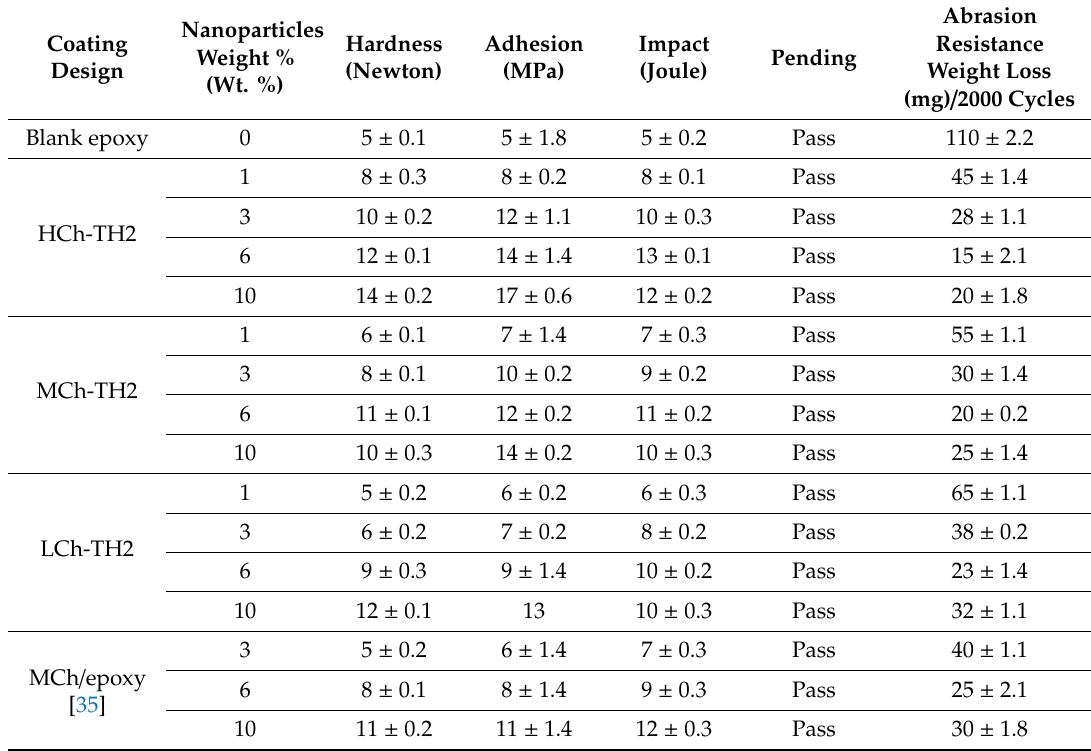
Table 2. Mechanical properties of cured DGEB / PA epoxy films in the absence and presence of di ff